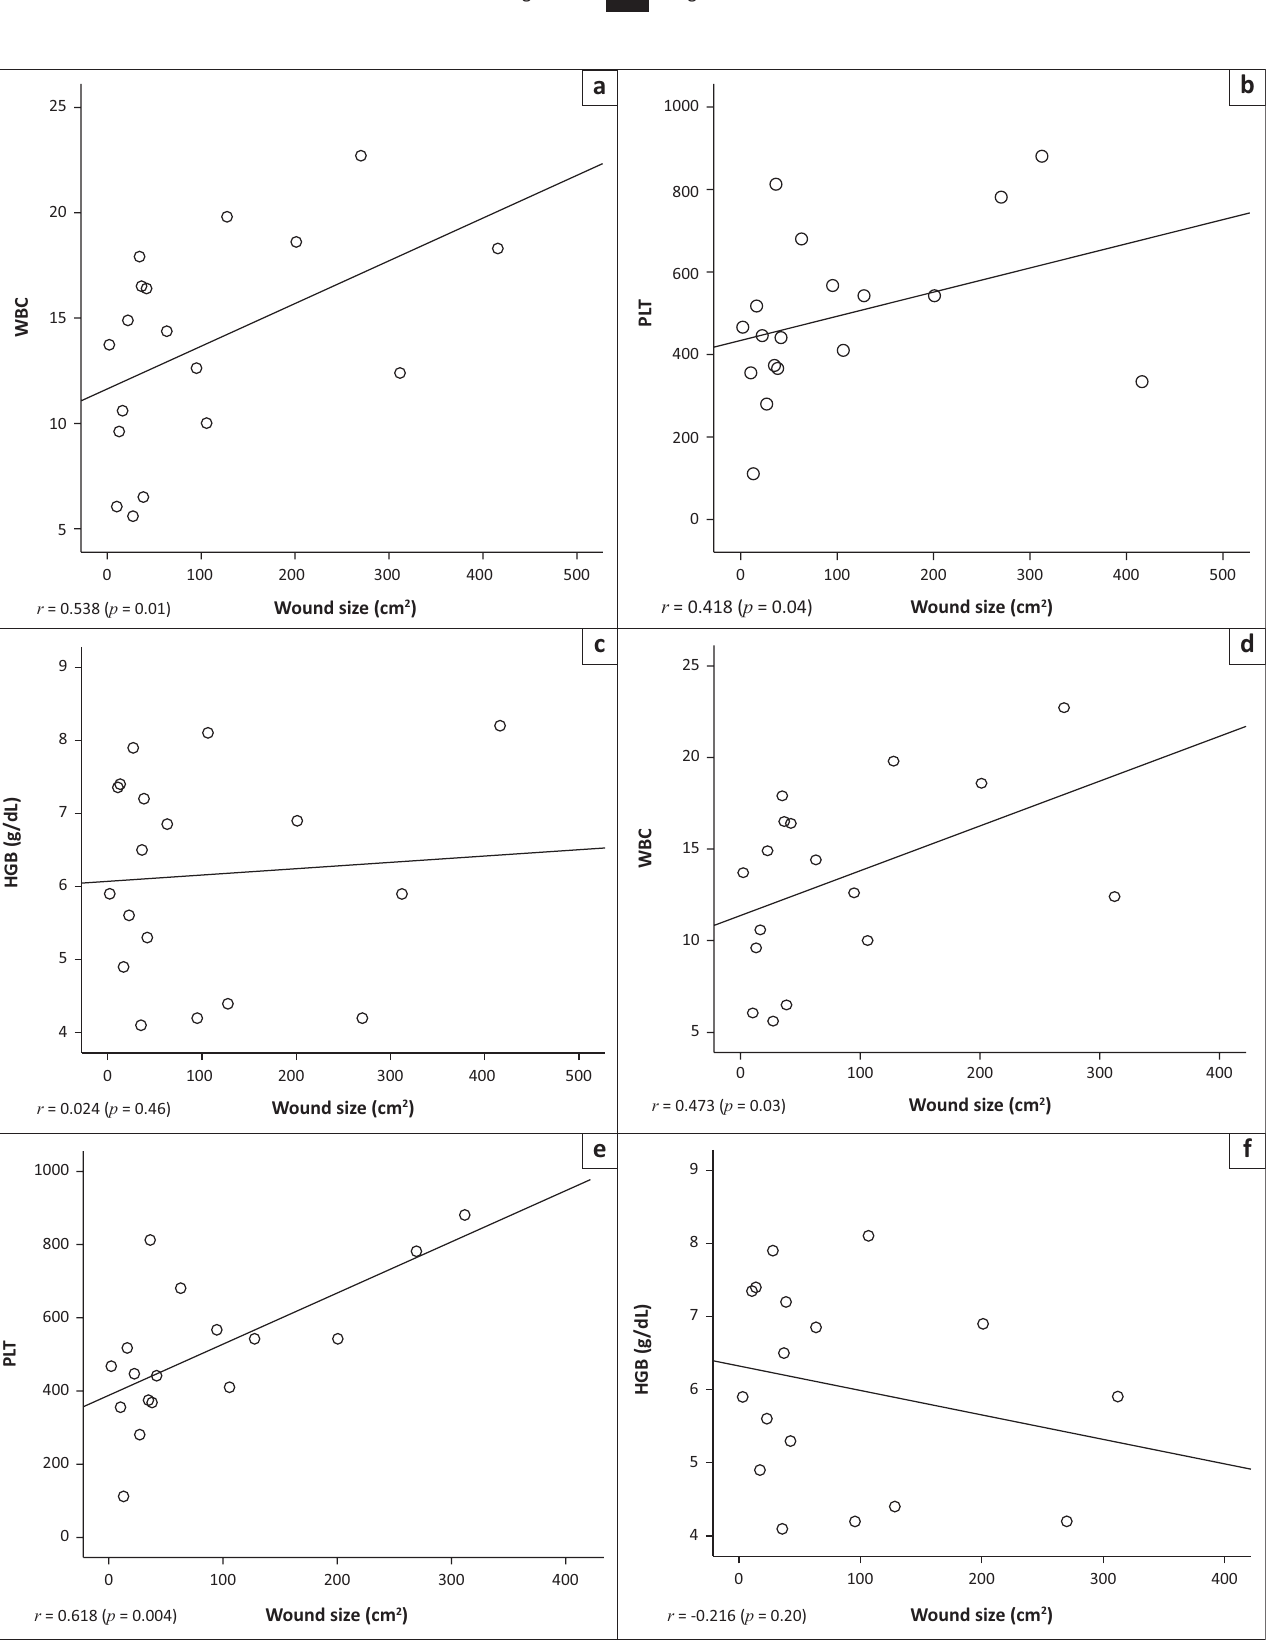
Note: Wound size and haematological parameters were more significantly correlated at T on exclusion of the patient with the highest haemoglobin concentration from analyses. 0 WBC, white blood cell count; PLT, platelet count; HGB, haemoglobin concentration. in adult sickle cell anaemia patients with chronic leg ulcers at the University FIGURE 1: Correlation between wound size and some haematological parameters at T 0 College Hospital and Ring Road State Hospital, Ibadan, Nigeria, March–June 2015. Correlation between wound size (cm 2 ) and (a) Wound size versus white blood cell count (10 3 / µ L), (b) Wound size versus platelet count (10 3 / µ L) and (c) Wound size versus haemoglobin concentration (g/dL) in all the leg ulcer patients. Correlation between wound size (cm 2 ) and (d) Wound size versus white blood cell count (10 3 / µ L), (e) Wound size versus platelet count (10 3 / µ L) and (f) Wound size versus haemoglobin concentration (g/dL) excluding one leg ulcer patient with the highest haemoglobin concentration and biggest wound